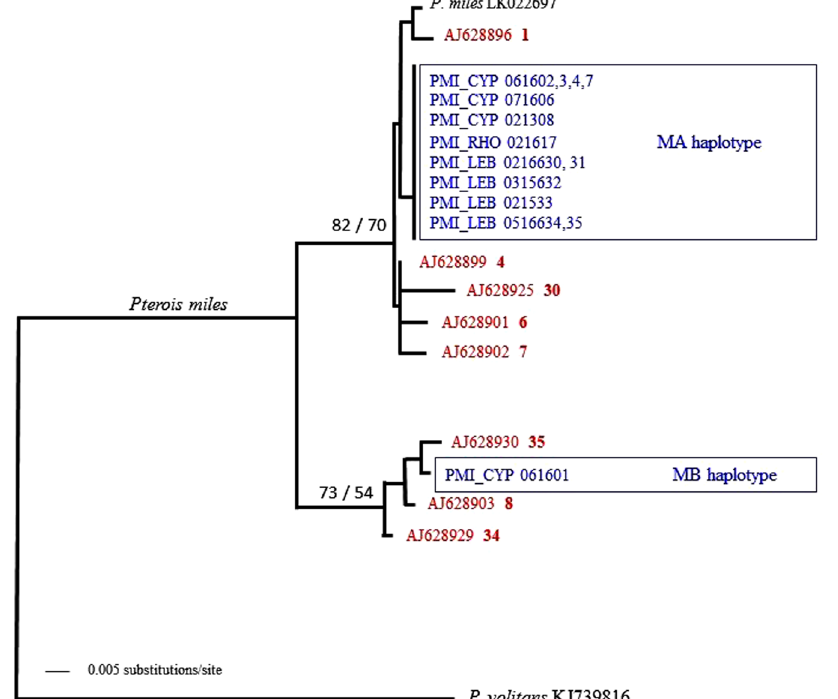
Figure 1. Neighbour-Joining (NJ) tree-based K2P distances of mitochondrial control regions of the common lionfish, Pterois miles , from the Red Sea (red, from GenBank) and the Mediterranean Sea (blue, sampled) (identical topology obtained using Maximum Likelihood, ML). Bootstrap support values higher than 50% are shown next to the corresponding nodes where the first value represents the NJ distance and the second value represents the ML value. PMI: Pterois miles ; CYP, Cyprus; RHO, Rhodes in Greece; LEB, Lebanon. GenBank accession and haplotype numbers are indicated 28 . In black is the control region extracted from a complete mitochondrial genome of P. miles from the Gulf of Aqaba and as an out-group from its congeneric P. volitans